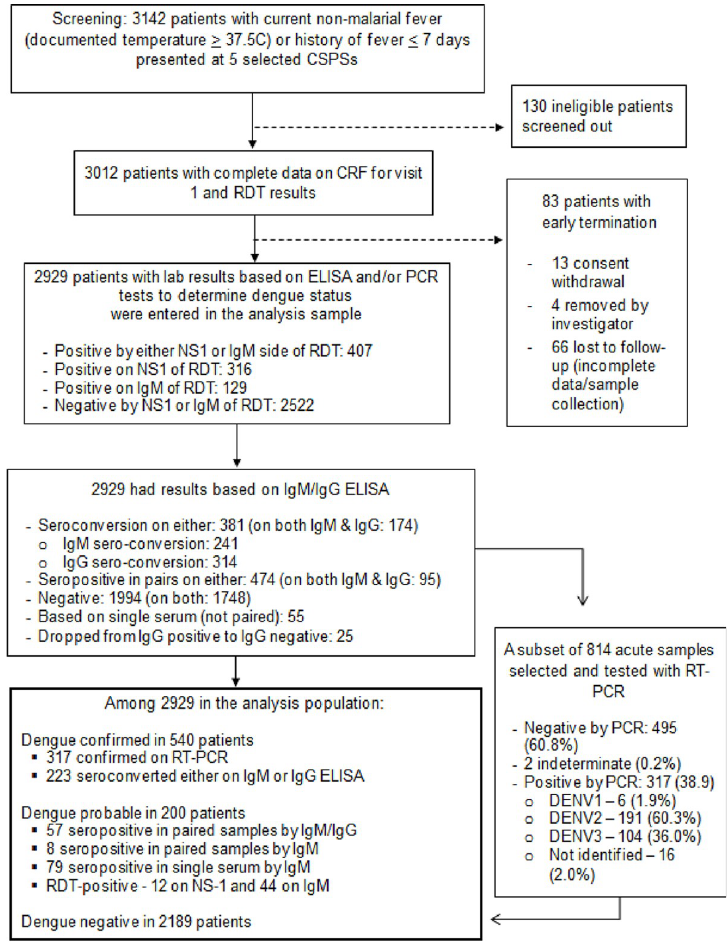
Fig 3. A chart of patient flow in passive fever surveillance. The diagram shows how we reached the study population and the test results from collected samples, within the